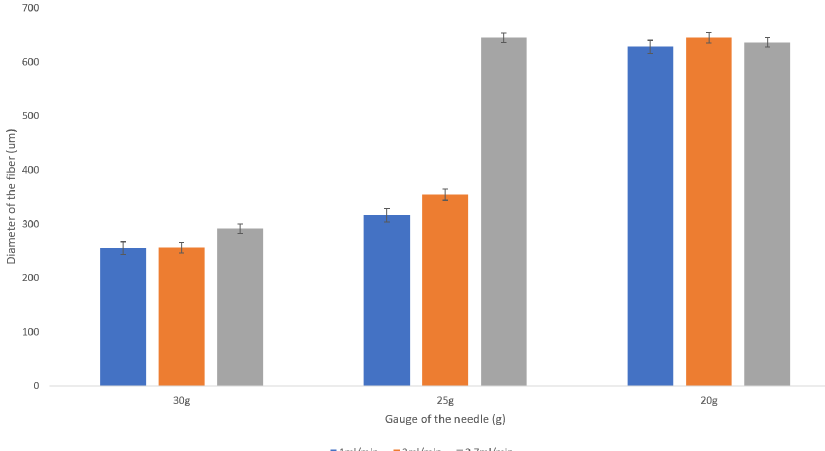
Figure 3. Dependence of the fiber diameter on the gauge of the needles for various concentrations of sodium alginate with the sodium alginate flow rate kept at 1 mL/min. The error bars represent the standard deviation of the measured diameters.